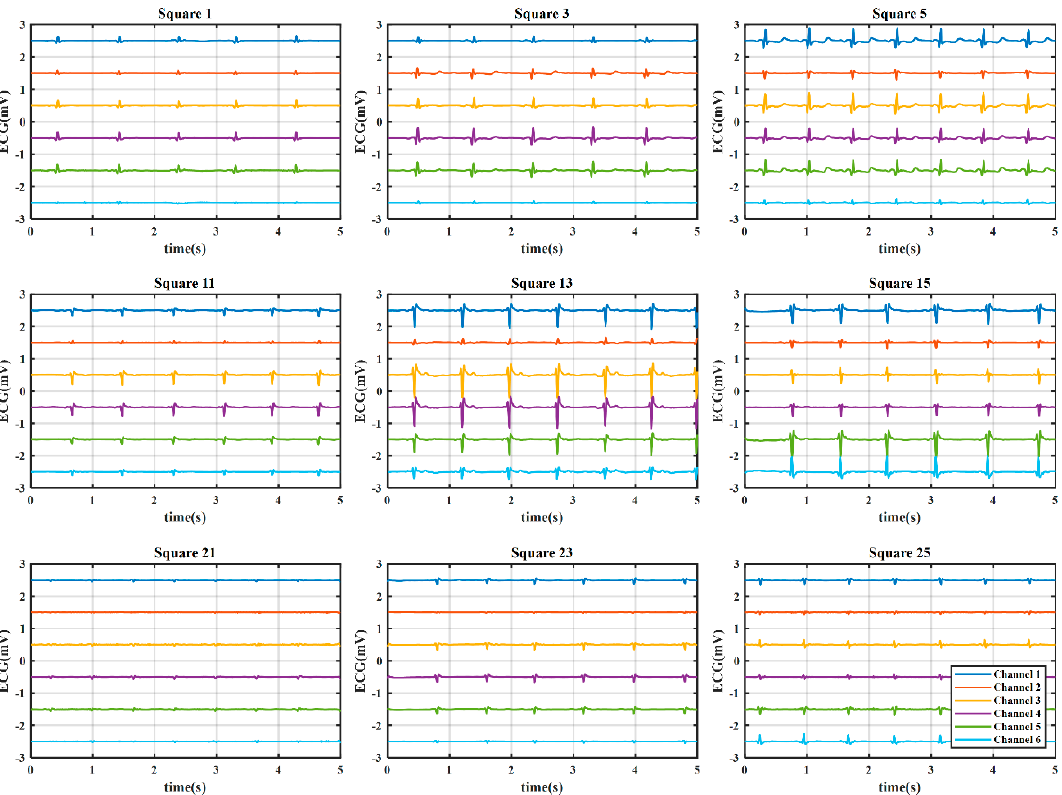
Figure 13. The typical six-channel ECG signals of the coarse-grained squares on the human body. The o ff set between the adjacent channels was 1 mV, and the vertical ordinate only indicated the relative value.